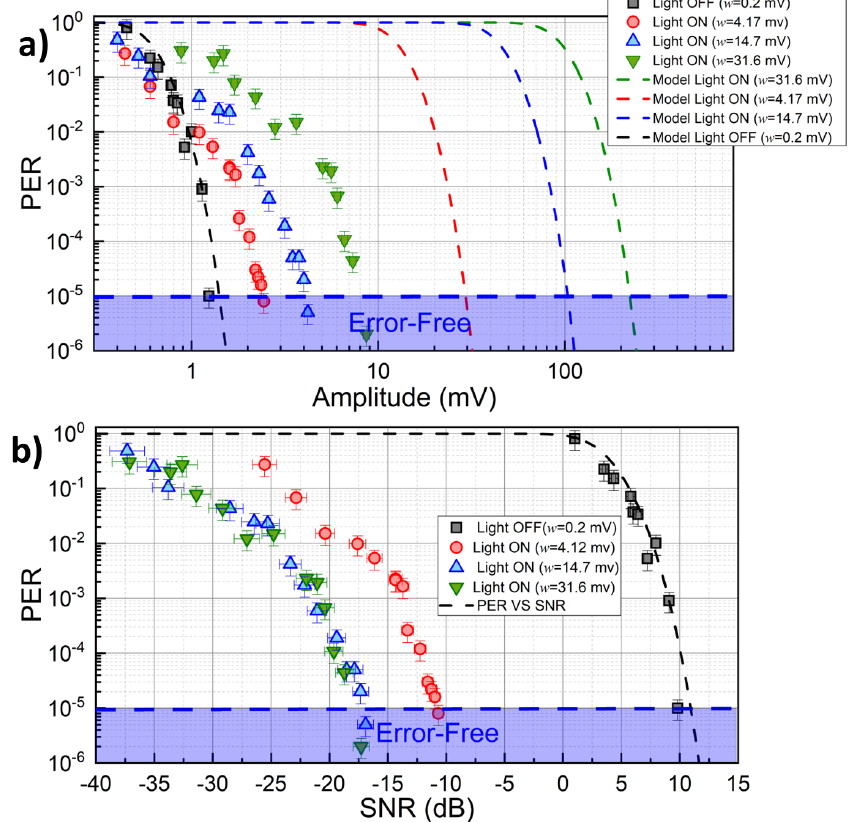
Figure 5. Effect of indoor background light intensity on communication quality in terms of PER, for 3 different levels of background illuminance: ( a ) PER vs. signal amplitude at the receiver, ( b ) PER vs. measured